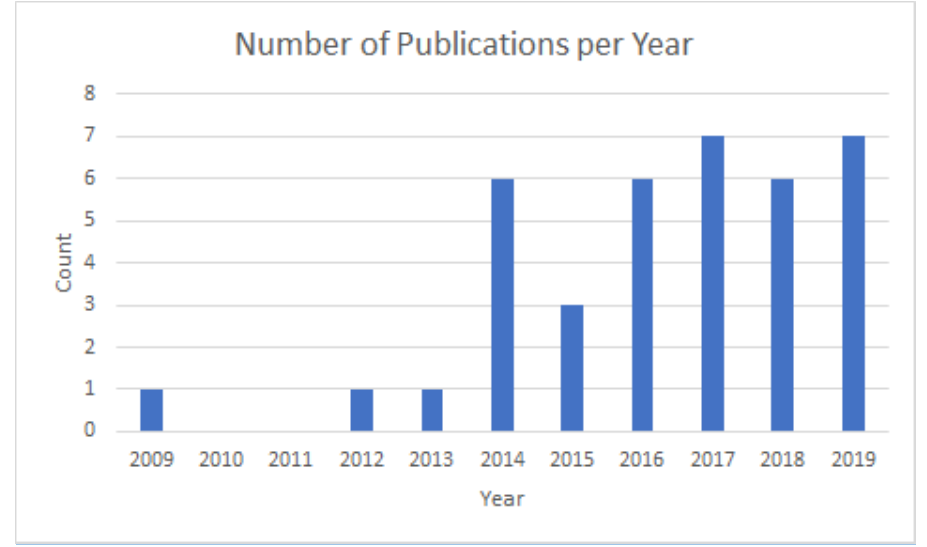
Figure 2. Publication count by year for the 38 studies related to AFEA, beverages, and/or packaging.